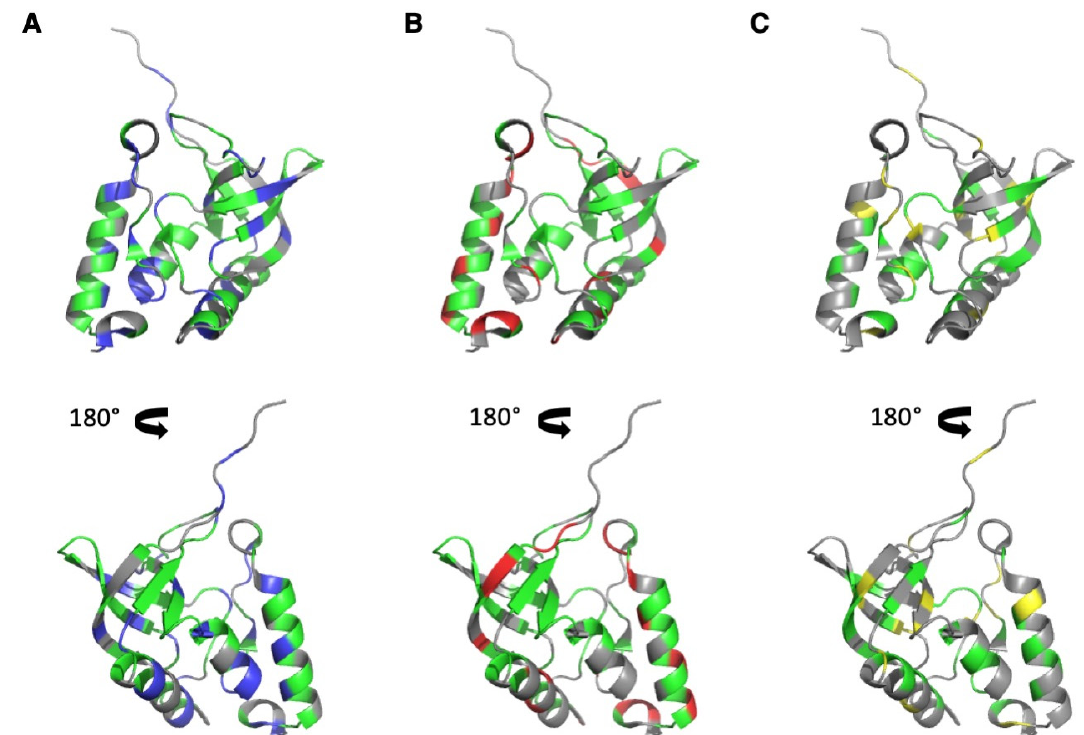
Figure 2. Distribution of the NMR probes used for the HP-NMR denaturation study on the 3D structure of ∆ +PHS SNase (PDB ID: 3LX0). ( A – C ): Two views (180 ◦ rotation along the vertical axis) of a cartoon representation of the 3D structure of ∆ +PHS Staphylococcal Nuclease. In ( A , B ), the colored residues correspond to the NH ( A ) (in blue and green) and C α H α ( B ) (in red and green) groups, which were assigned and gave neither overlapping cross peaks in the folded state nor in between the folded and unfolded states at 20 ◦ C in the corresponding HSQC spectra. The residues colored in green correspond to residues where both the NH and the C α H α groups gave no overlapping cross peaks. In ( C ), the colored residues (in yellow and green) correspond to all methylated residues. Those colored in green correspond to residues that gave no overlapping in the 2D [ 1 H, 13 C] HSQC spectra (folded and unfolded states). In this figure, all residues colored in green were used for the HP NMR